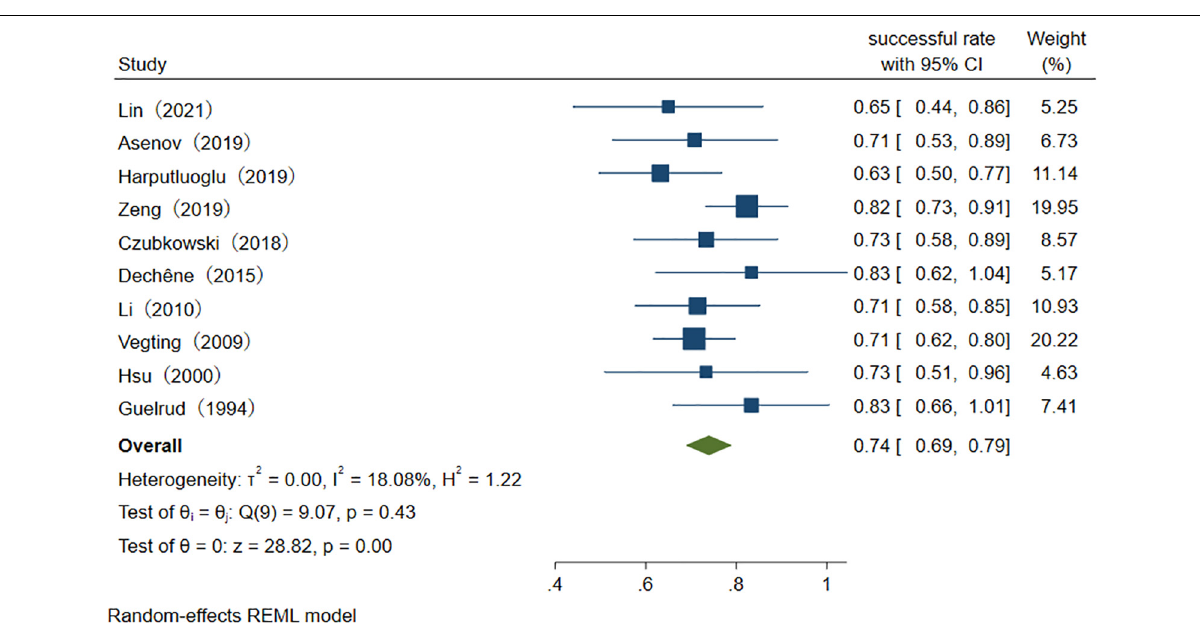
of diseases that benefit similarly from therapeutic